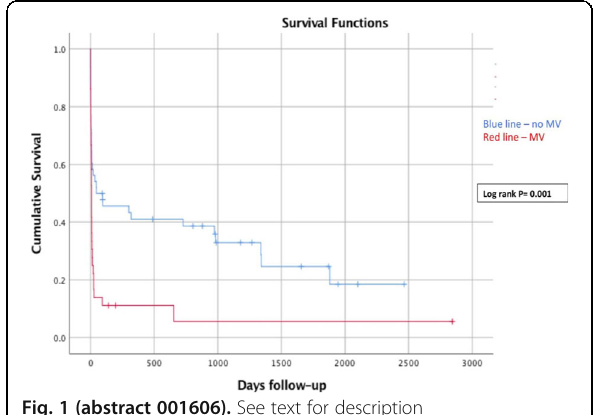
Fig. 1 (abstract 001606). See text for